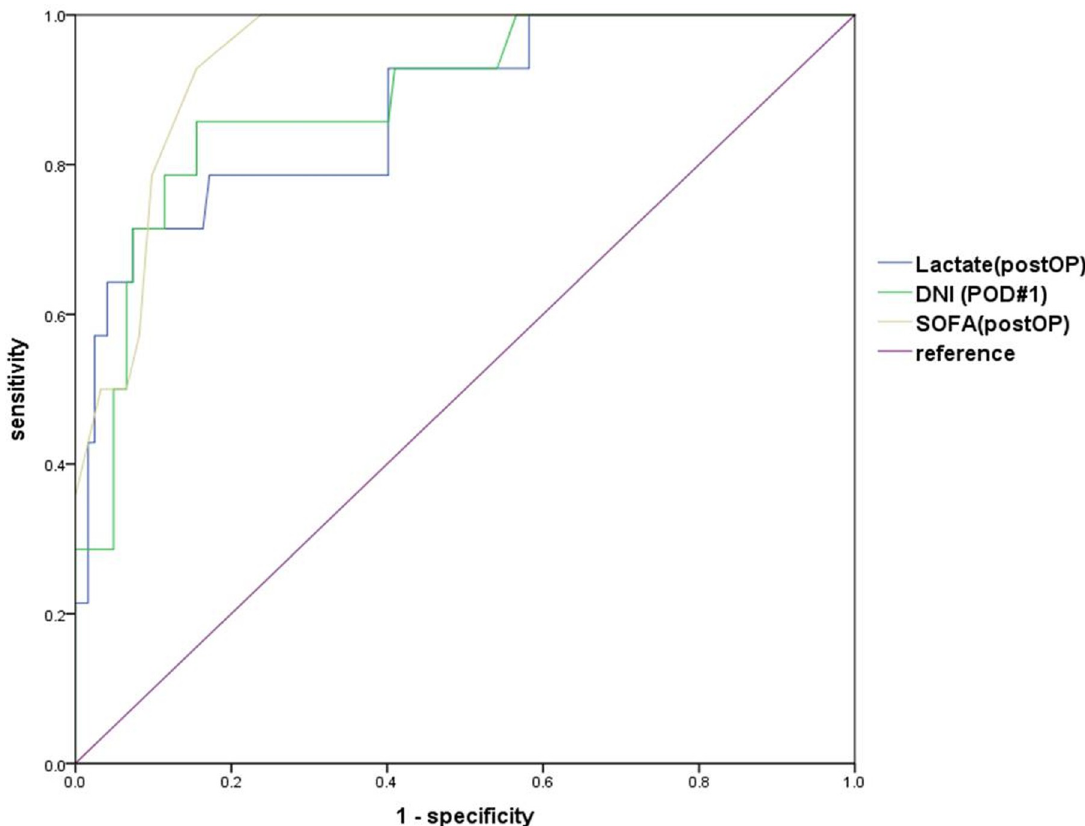
Fig 3. Receiver operating characteristics (ROC) curves for the delta neutrophil index (DNI) (postoperative day 1, POD1), lactate (immediate postoperative, PostOP), and sequential organ failure assessment (SOFA) score (PostOP) between the survivors and